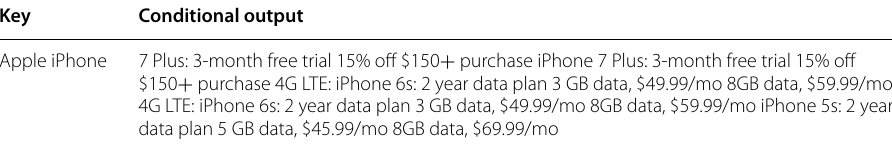
Automatic output generated by the trained model against user given topic/key